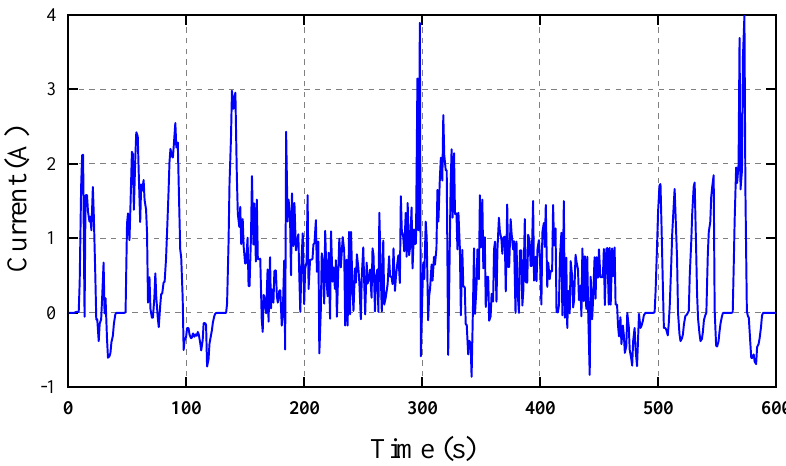
Figure 7. Battery current excitation curve under the US06 working condition.